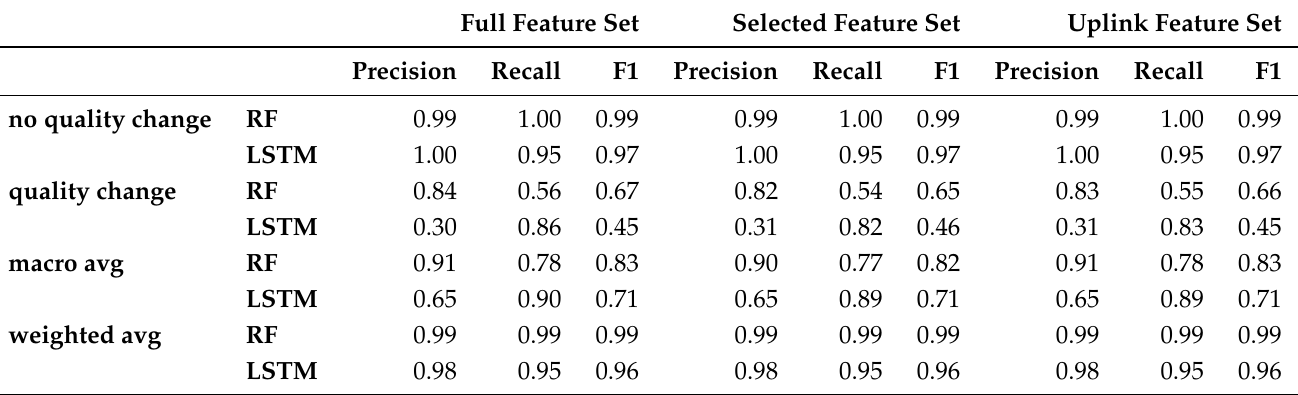
Table 15. Quality change prediction